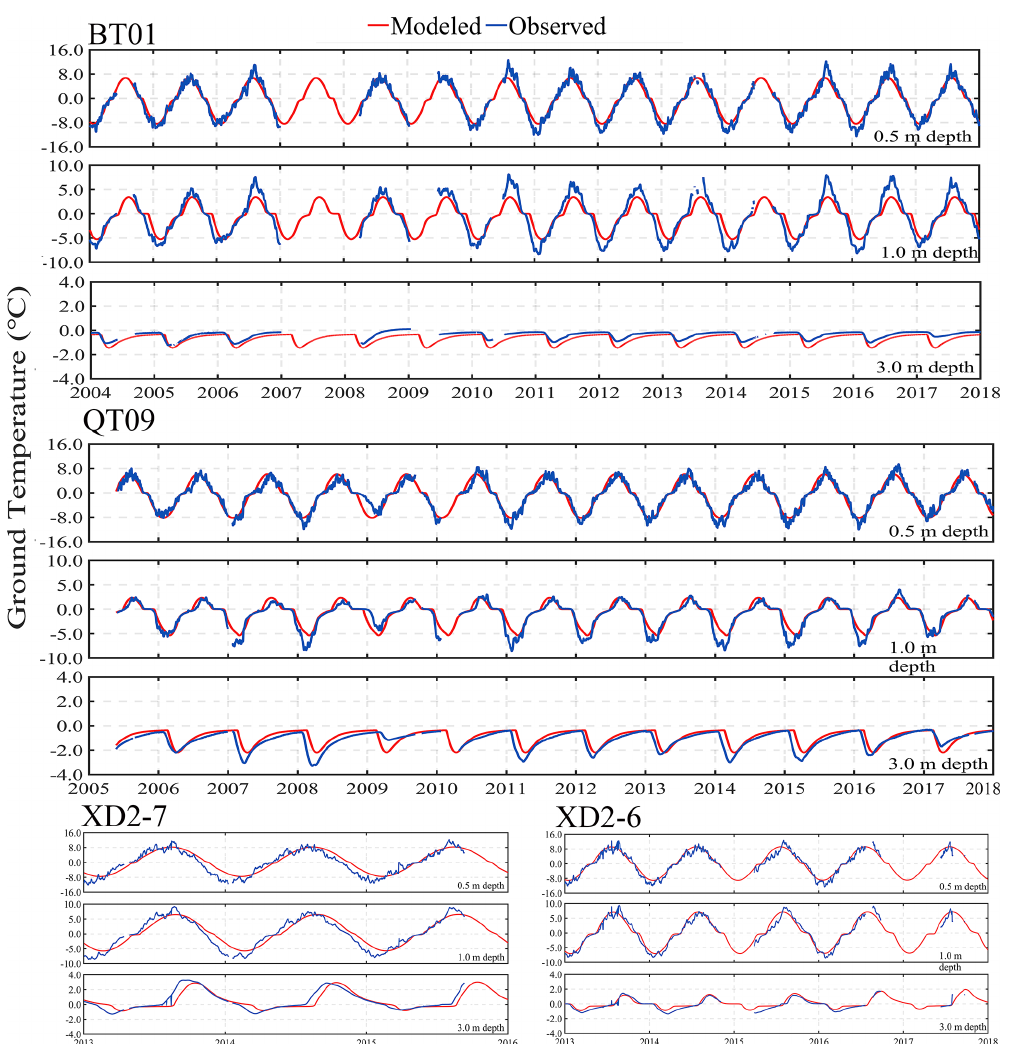
Figure A1. Comparison of the simulated (red lines) to observed (blue lines) daily mean ground temperature at 0.5, 1.0, and 3.0m depth in four calibration boreholes (BT01, XD2-7, QT09, and XD2-6) during the observation period (there were some data gaps due to temperature probe failure in some years; at BT01, the data gaps in the record mainly occurred at 0.5–15m in 2007–2008 and at 15–30m during 2005– 2007 and 2011–2018; at QT09, observations at 15–30m of 2006–2008, 2011–2013, and 2015–2018 are not available; at XD2-6, the data gap in the record is in